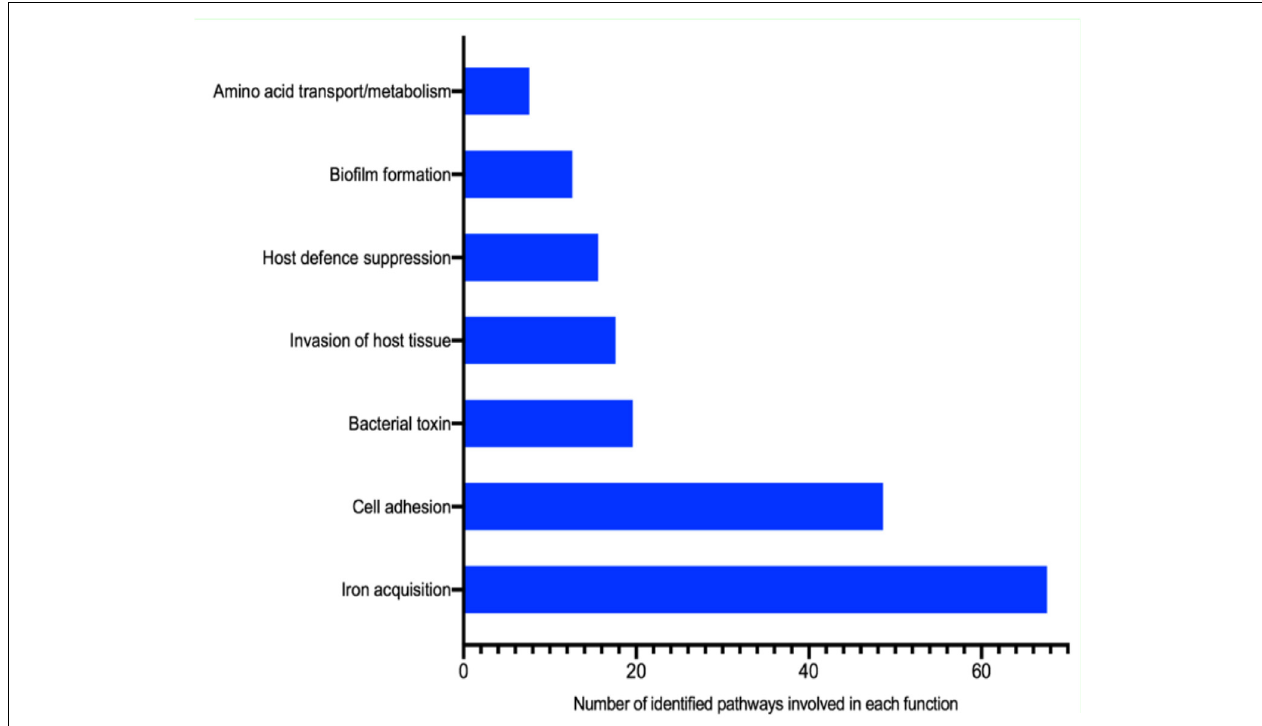
FIGURE 7 | Identified bacterial virulence factors in DFIs using the